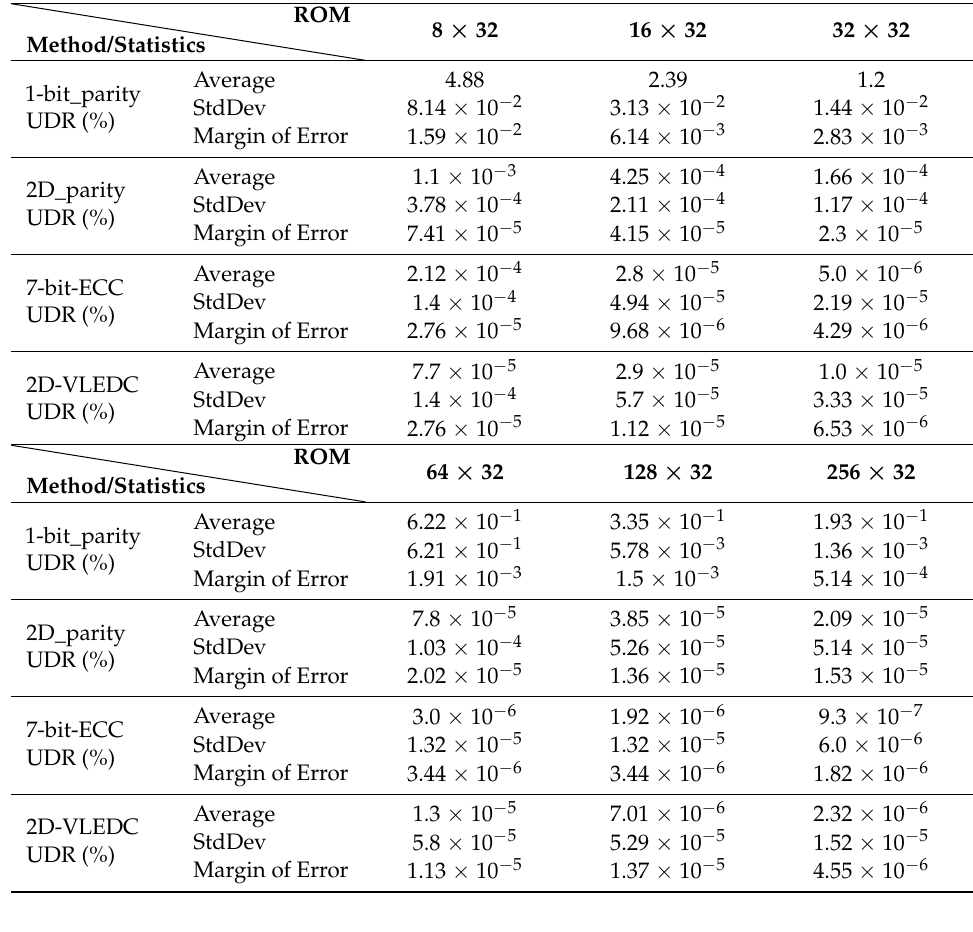
Table 3. The comparison of the overhead of redundant bits. ROM (Read only memory); UDR (Un-Detected error Rate); StdDev (Standard Deviation).